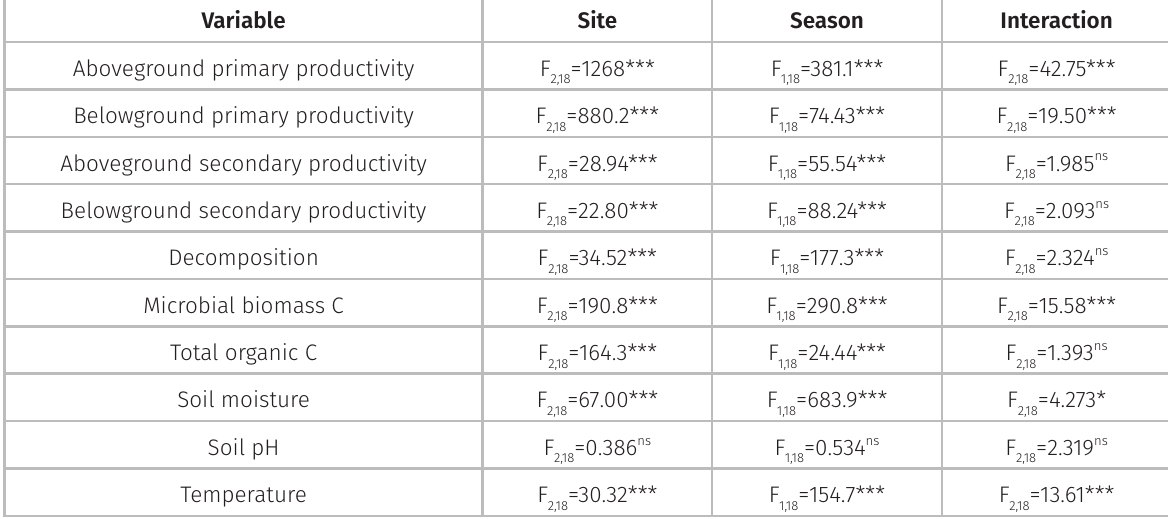
Table II. Linear mixed models on the effects of sites (CG, CSS, and CD), seasons (dry and wet), and interactions on ecosystem